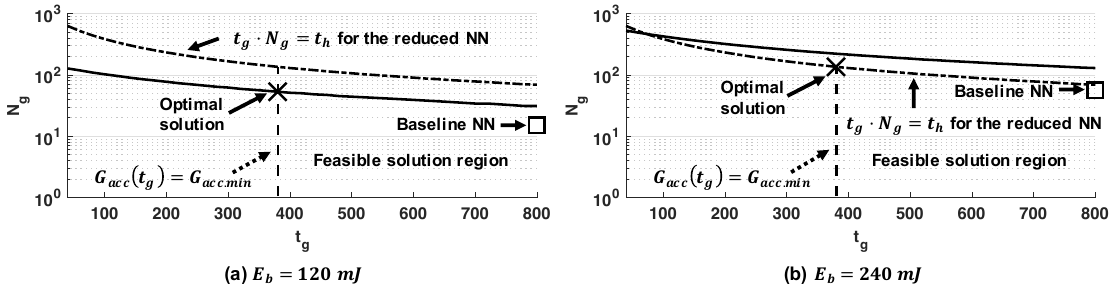
Figure 11. Illustration of the optimal solution for different energy budgets when the energy storage voltage is 2.7